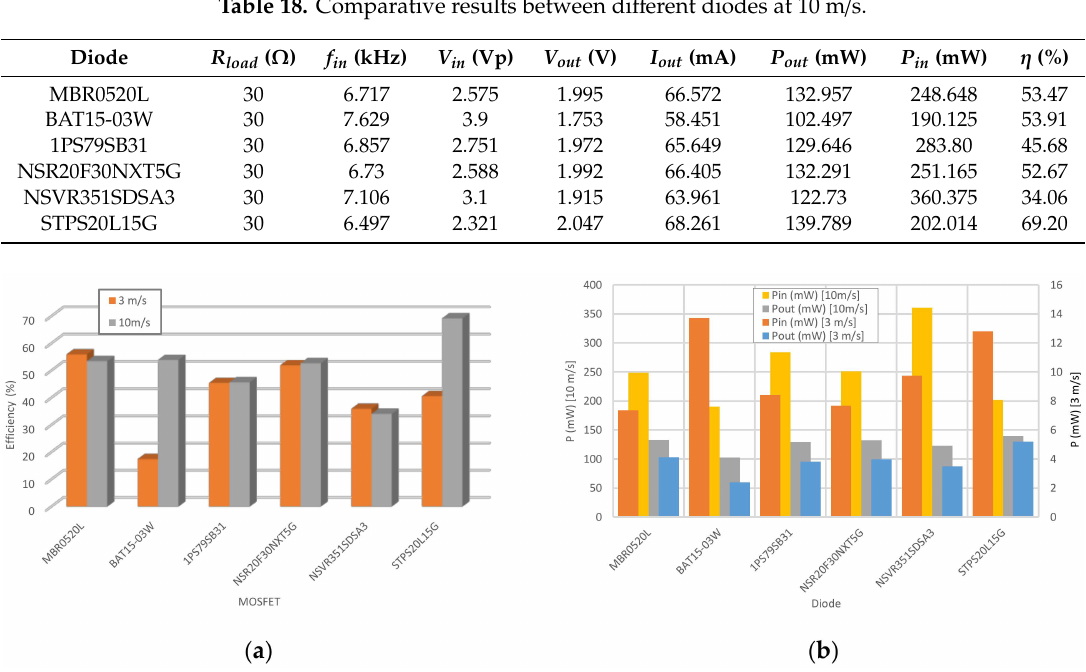
Figure 29. Comparisons between diodes at 3 m / s and 10 m / s. ( a ) E ffi ciency. ( b ) Input / output